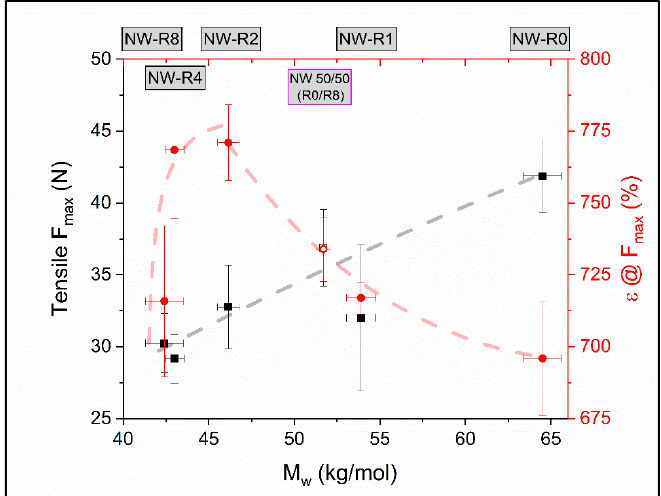
Figure 10. Force at break ( F max ) and elongation at break ( ε @ F max ) as a function of M w for various nonwovens (NW0-NW8, closed symbols) and a nonwoven made of 50/50 wt % mixture of R0 and R8 (open symbol). The dashed lines are a guide to the eye.